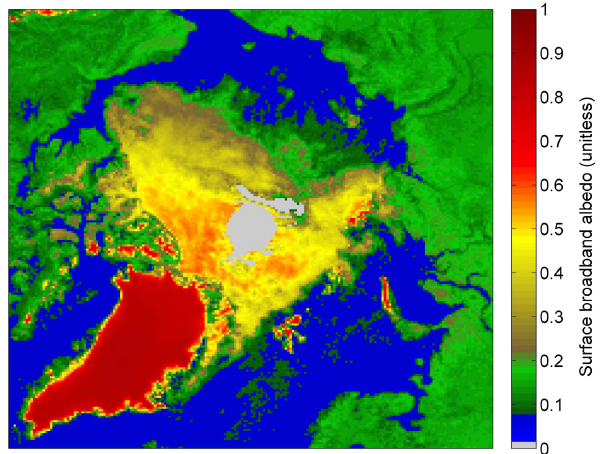
Fig. 1. An example of the Arctic CLARA-SAL monthly mean prod- uct from August 2007. Grid cell size is 25